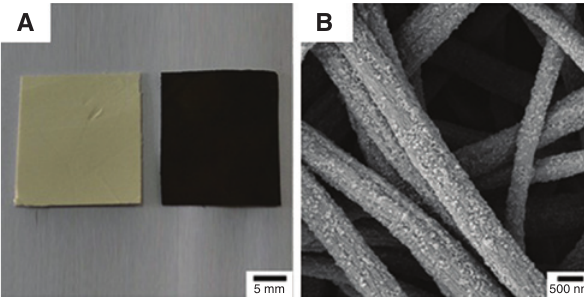
Figure 12: (A) Digital photo of TP/pluronic/PS membrane (left) and Ag-TP/PS membrane (right); (B) SEM images of Ag-TP/PS membrane. For details, see Ref. [49]; reprinted with permission from